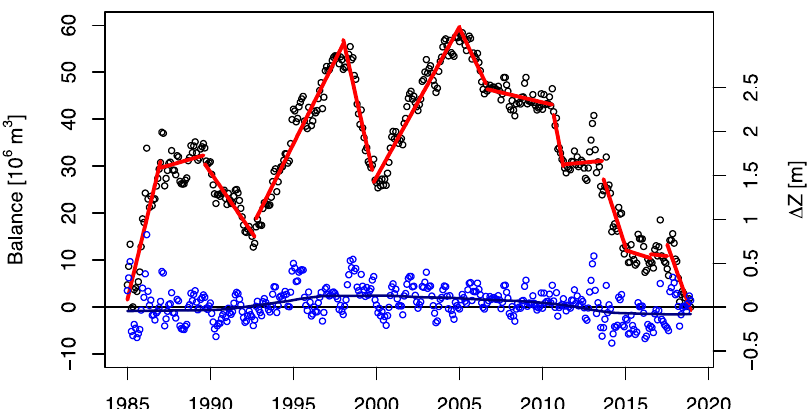
Figure 4. Cumulated water balance of Lake H based on raw measurements and a simple correction for long-term trend ( black circles ) and corrected discharges ( blue circles ). Red straight lines indicate manually delineated periods of constant systematic errors, blue line is a local polynomial regression (LOESS) on the corrected discharge. Right axis shows approximate change in storage